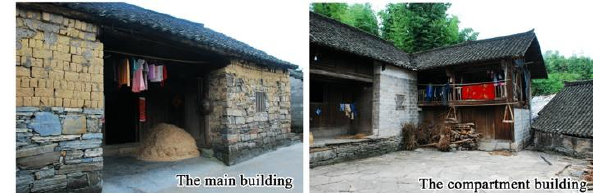
Figure 3. The main building and the compartment building.